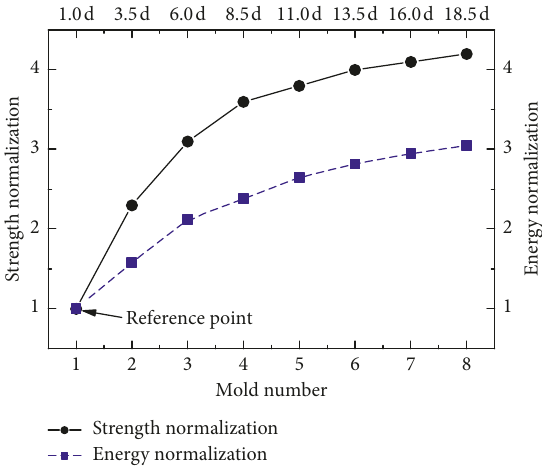
Figure 10: Comparison of the normalized cumulative energy and dynamic tensile strength for each mold of the shaft